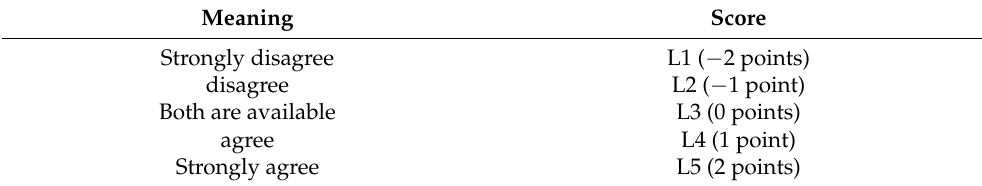
Table 2. Semantic evaluation